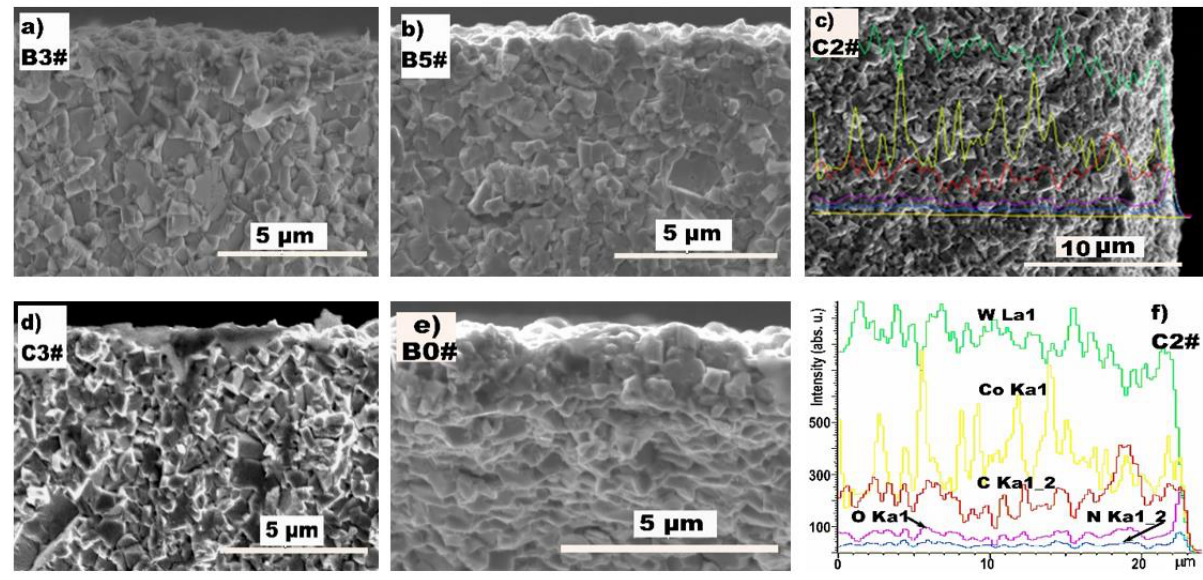
Figure 2. ( a – e ) The cross-sectional images of specimens B3#, B5#, C2#, C3#, and the untreated specimen B0#. ( f ) The line scanning of EDS of the specimen C2# nitrided for 6 h.